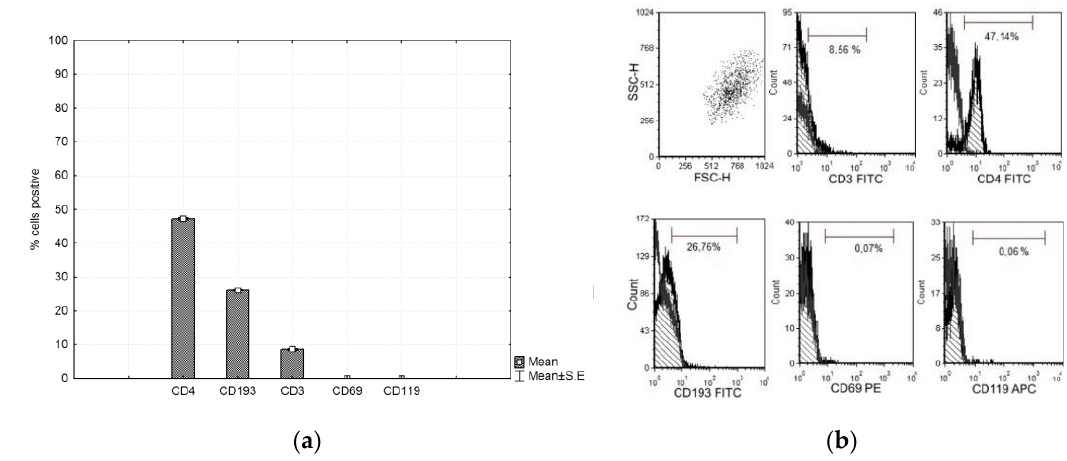
Figure 4. ( a ) Phenotype expression of markers of the phytohemagglutinin (PHA) lymphocyte. Histograms represent mean ± S.E of seven independent experiments and ( b ) representative flow cytometry analysis for lymphocytes.